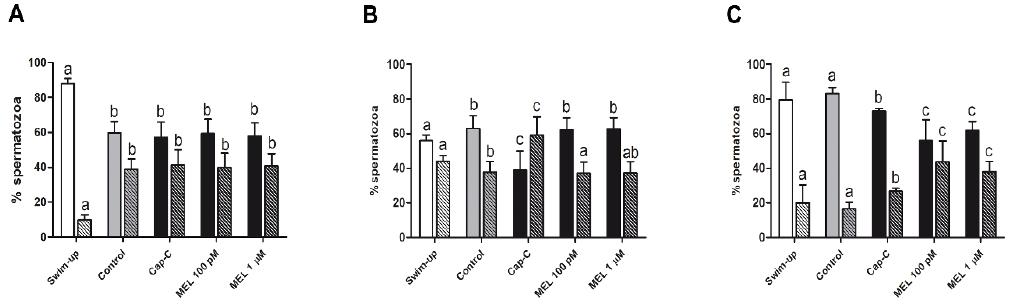
Figure 8. Percentages of the immunotypes for eNOS ( A ), nNOS ( B ) and iNOS ( C ) in swim-up selected (white bars) and in vitro capacitated ram spermatozoa without (control, grey bars) or with cAMP-elevating agents (Cap-C, black bars), and with melatonin (MEL) 100 pM and 1 µM. Plain bars represent immunotype 1 for eNOS (postacrosomal region + neck + apical edge) and immunotype 3 for iNOS and nNOS (postacrosomal region + apical edge), whereas striped bars represent immunotype 2 (postacrosomal region + apical edge) for eNOS and immunotype 4 (postacrosomal region) for iNOS and nNOS. Results are shown as mean ± SEM ( n = 5). Different letters indicate statistical differences between treatments ( p < 0.05).